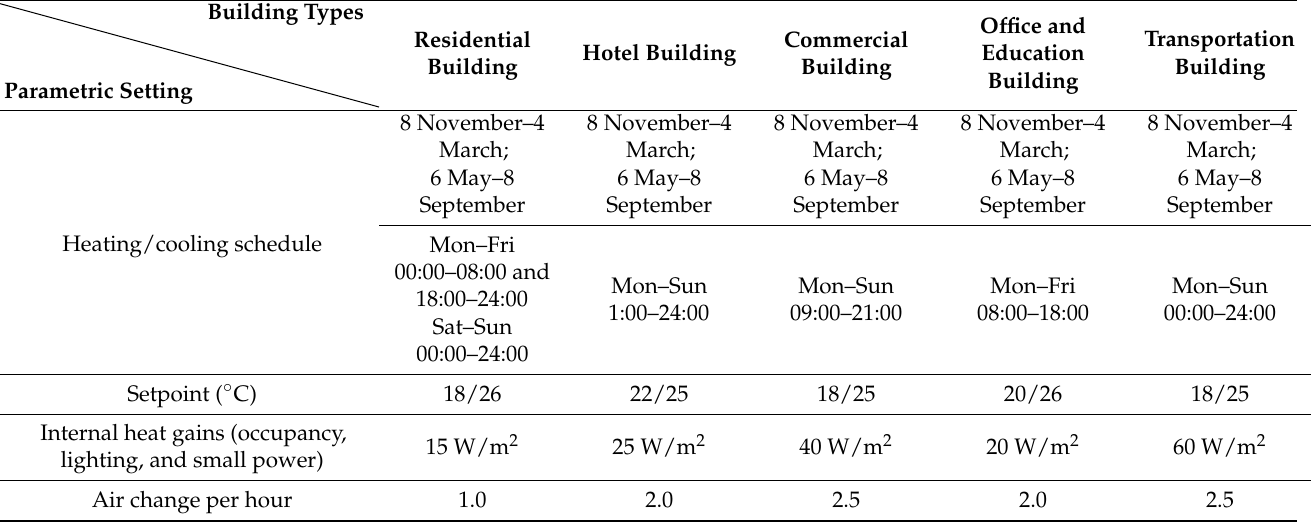
Table 5. The parametric setting for urban building energy simulation (the design standard for energy efficiency of residential buildings in hot summer and cold winter zone (2010); the design standard for energy efficiency of public buildings (2015)).